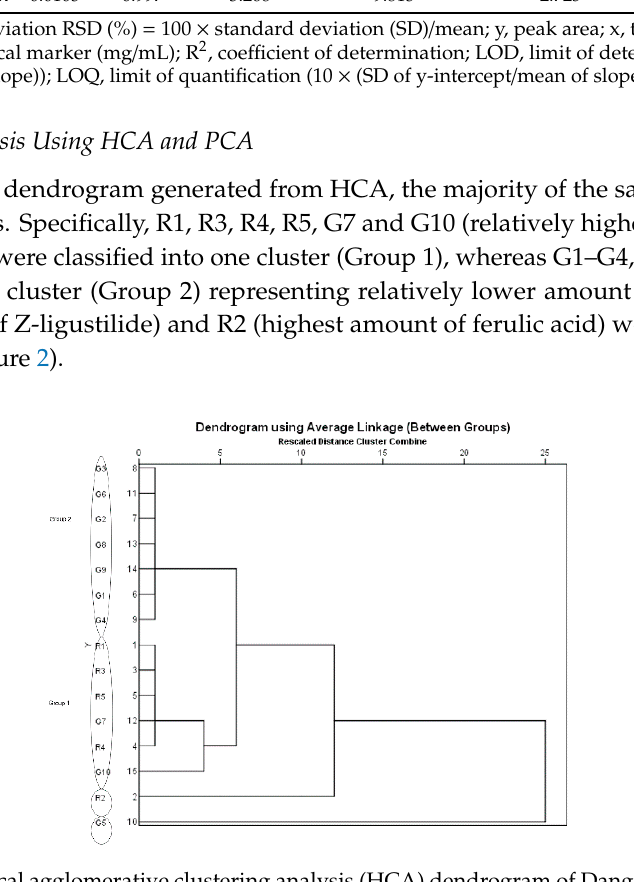
Figure 2. Hierarchical agglomerative clustering analysis (HCA) dendrogram of Danggui samples using SPSS 20.0 software (Chicago, USA). Ward’s method as amalgamation rule and the squared Euclidean distance as metric were employed to set up the clusters. The length of the linkage between each sample / group represents the degree of similarity. G: granule samples; R: raw herbs / decoction piece samples. Group 1: R1, R3, R5, G7, R4, G10; Group 2: G1, G2, G3, G4, G6, G8, G9. R2 and G5 are outliers.